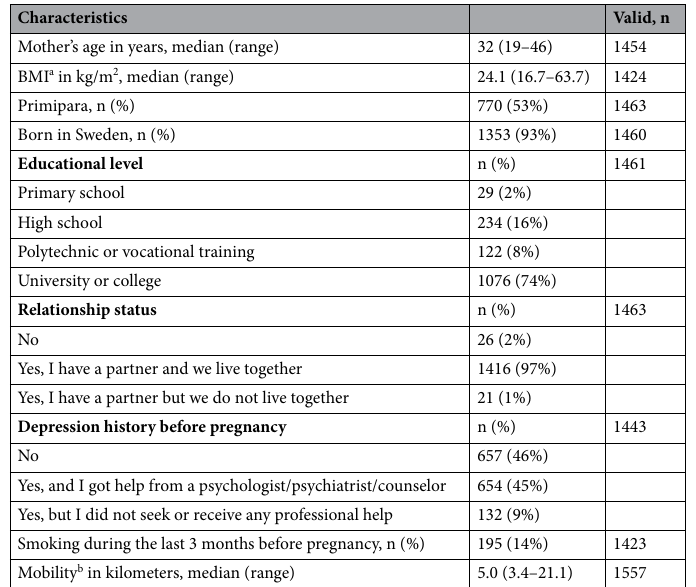
Table 1. Background characteristics of the participating women in the Mom2B-study (n = 1577). a Body Mass Index. b Distance travelled away from home per